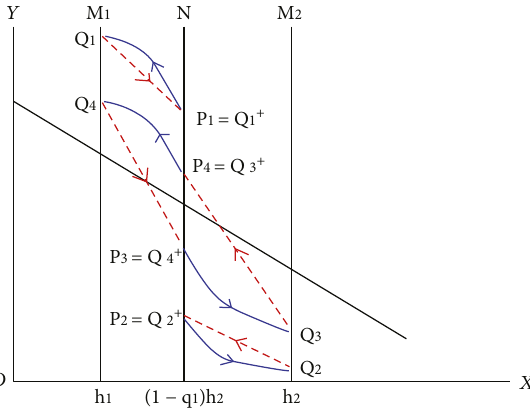
< h 2 of system (3). 1 h 2